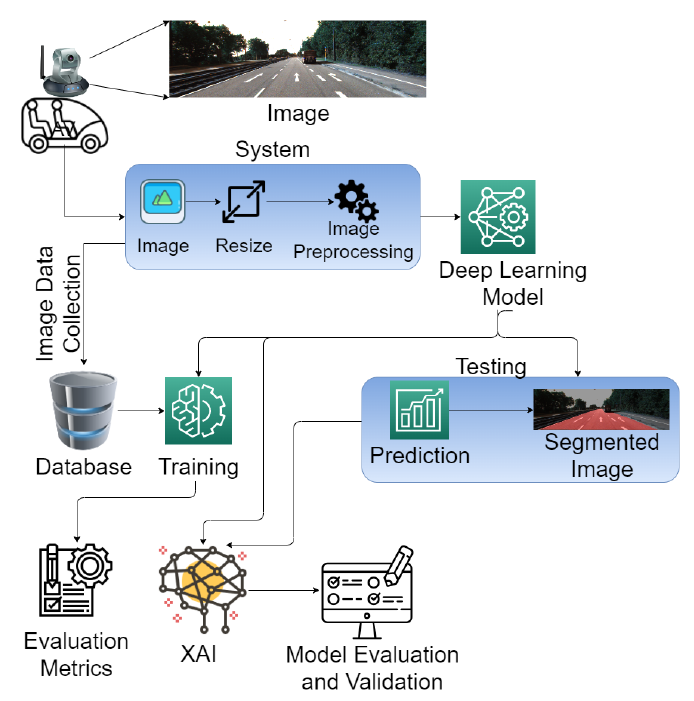
Figure 3. OD-XAI : system